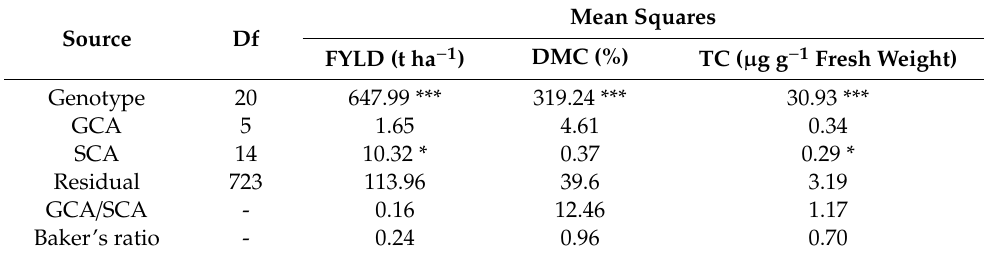
Table 3. Analysisofvarianceforthegenotypesandforthecombiningabilityofthestudiedcharacteristics.